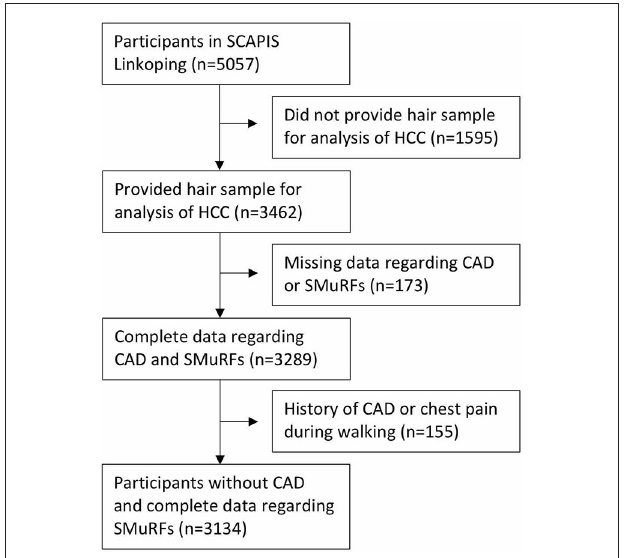
FIGURE 1 | Flow diagram over included participants from the SCAPIS study. HCC, hair cortisol concentration; CAD, coronary artery disease; SMuRF, standard modifiable risk factor; SCAPIS, Swedish CArdioPulmonary BioImage Study.